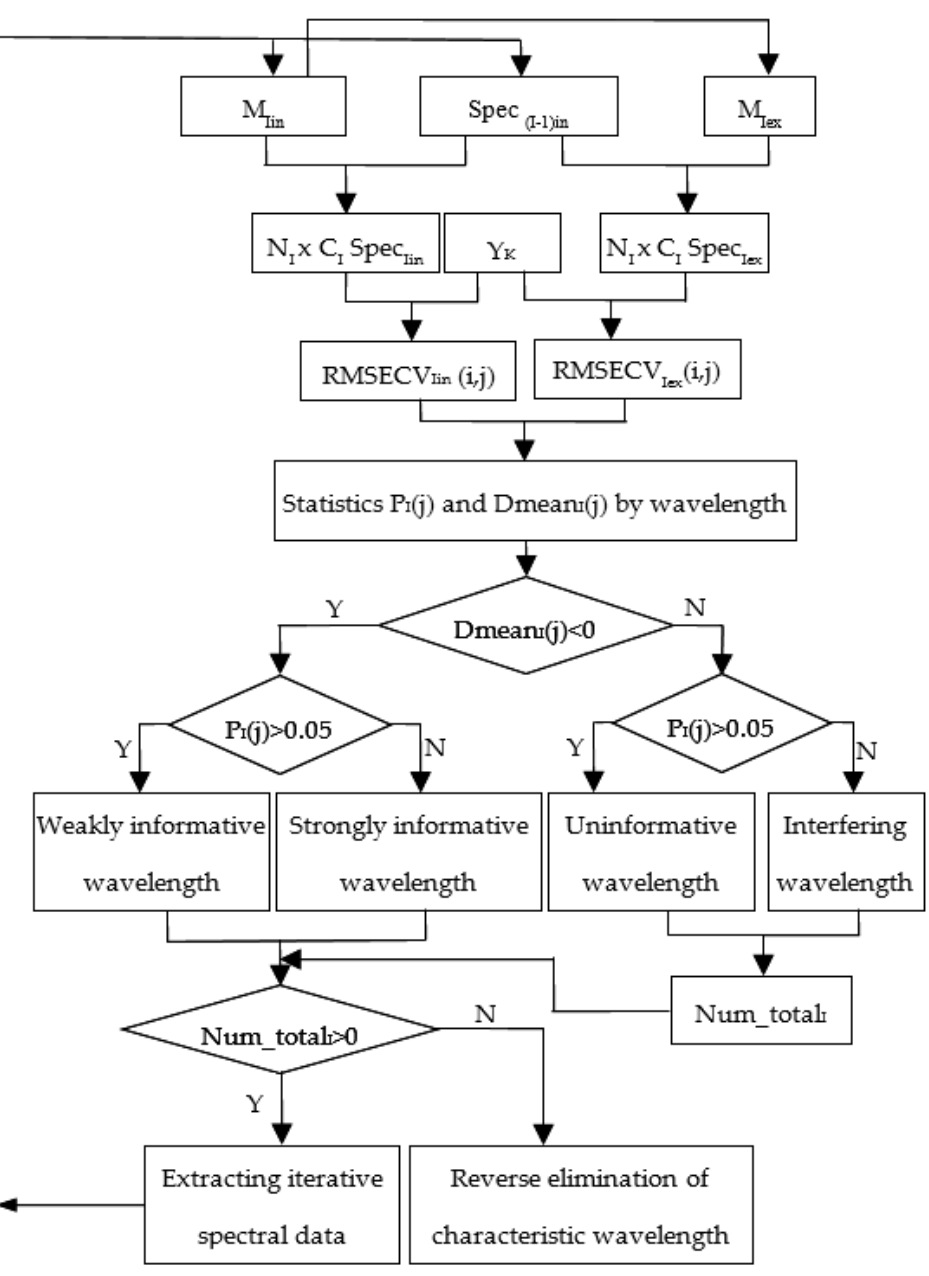
Figure 2. Iteration process of Round I.